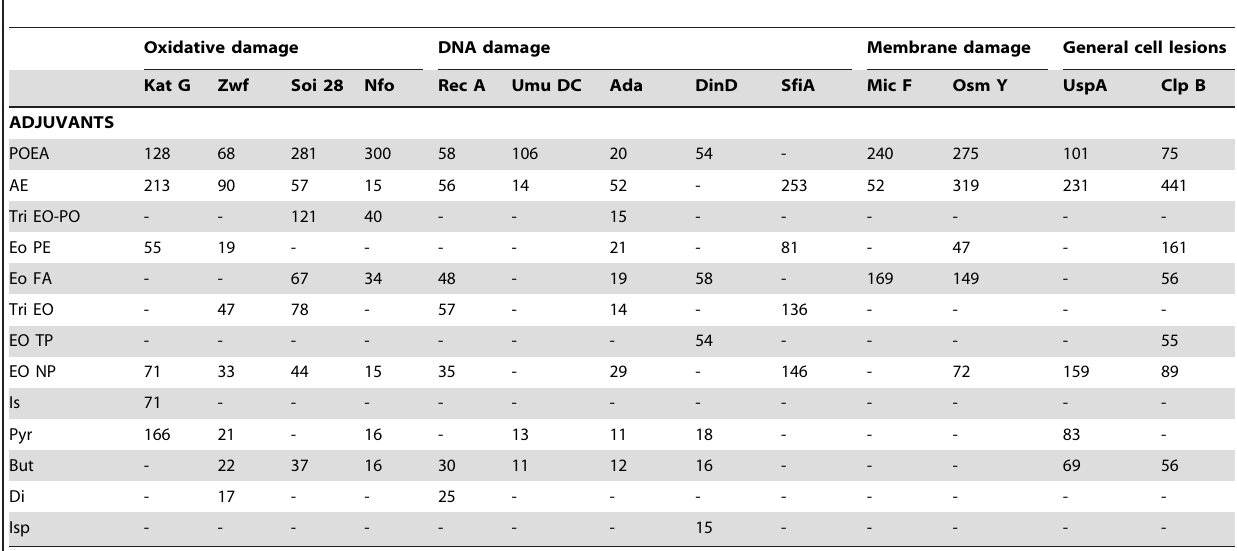
Table 3. Significantly induced effects at the gene expression level after exposure to the selected adjuvants.